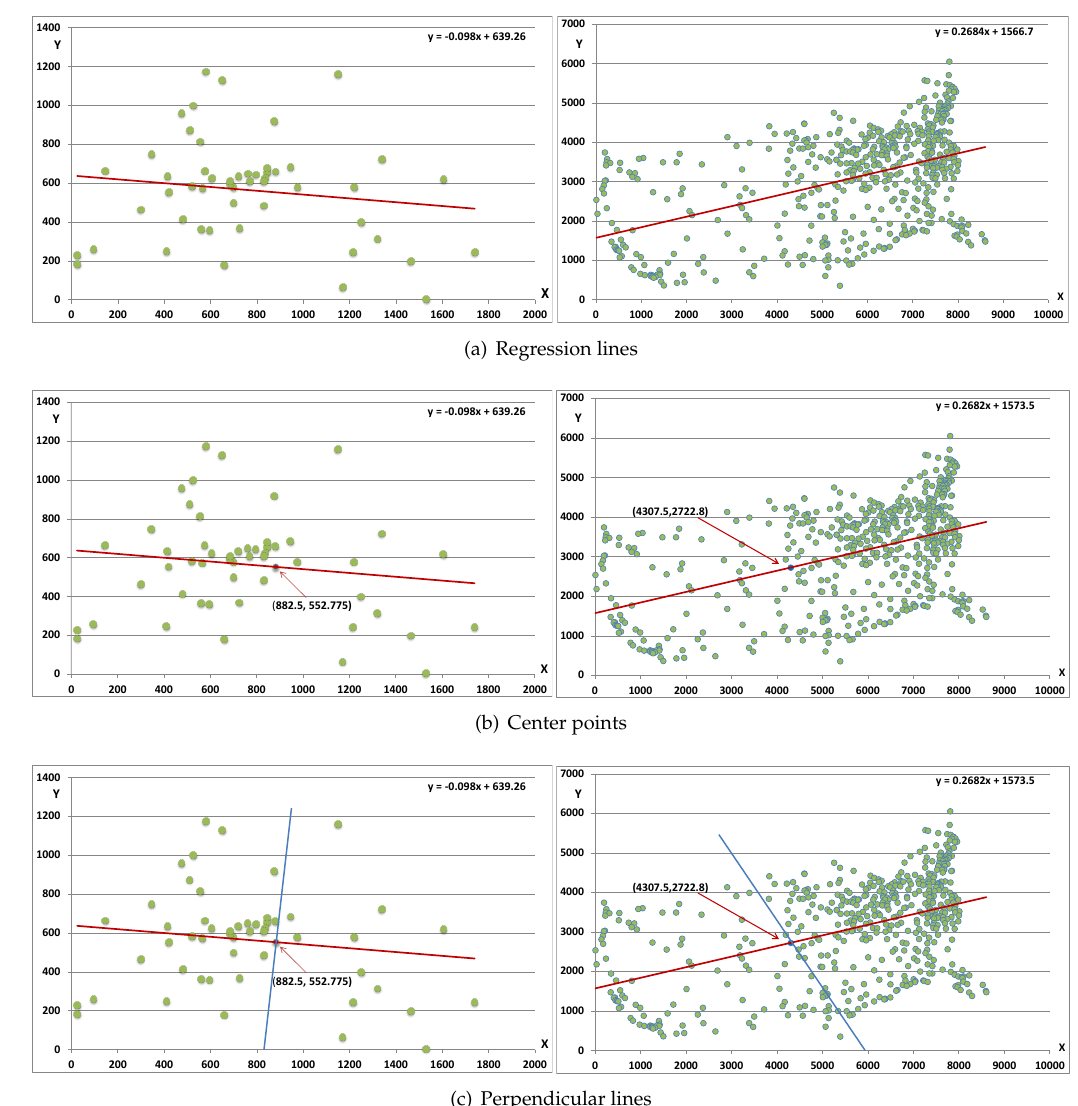
Figure 9. Examples of finding regression lines and corresponding perpendicular lines in proposed our regression-based technique on (Left) berlin52, (Right) att532 TSP cities. ( a ) The regression lines, ( b ) center points ( x , y ), ( c ) perpendicular lines that intersect with the regression lines at the center